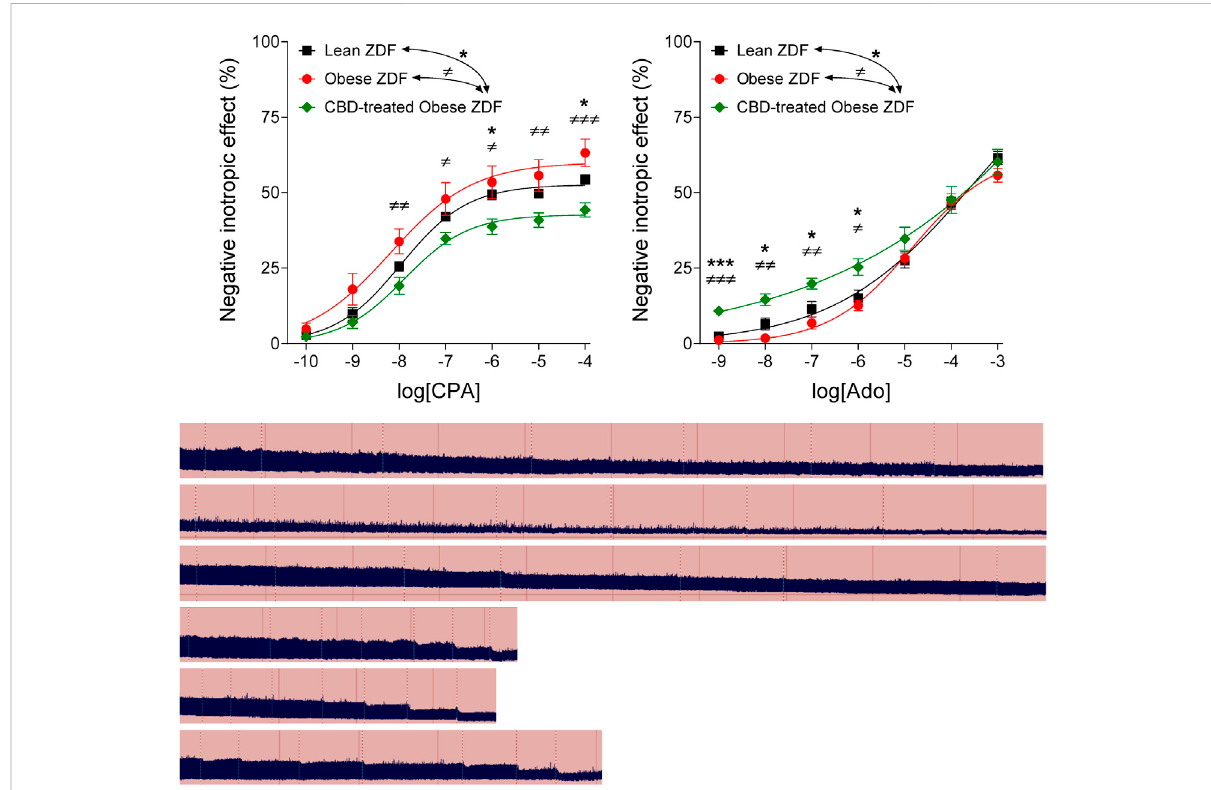
ThedirectnegativeinotropiceffectofCPAandadenosineinisolatedandpacedatriaofleanandobesetypesofZuckerDiabeticFatty(ZDF)rats, without or with a previous in vivo cannabidiol (CBD) treatment (for the obese ZDF rats). On the top, two x-y graphs are presented, while below, six original records are shown (top three: response to CPA; bottom three: response to adenosine; in the order of the labels on the graphs). The x -axis denotesthecommonlogarithmofthemolarconcentrationofthegivenagonist(inthebathingmedium),whilethe y -axisindicatestheeffect(as a percentage decrease in the initial contractile force). The symbols show the responses to the given agonist averaged within the groups (±SEM), and the curves illustrate the fi tted Hill equation (Eq. 1). The vertical dotted lines on the original records denote the administration of the agonist doses. CPA: N 6 -cyclopentyladenosine; Ado: adenosine; *: comparison of the CBD-treated Obese ZDF group (n = 6) with the Lean ZDF group ( n = 8); ≠ : comparison of the CBD-treated Obese ZDF group with the Obese ZDF group ( n = 4); the number of marks means the level of statistical signi fi cance (one mark: p < 0.05, two marks: p < 0.01, three marks: p <